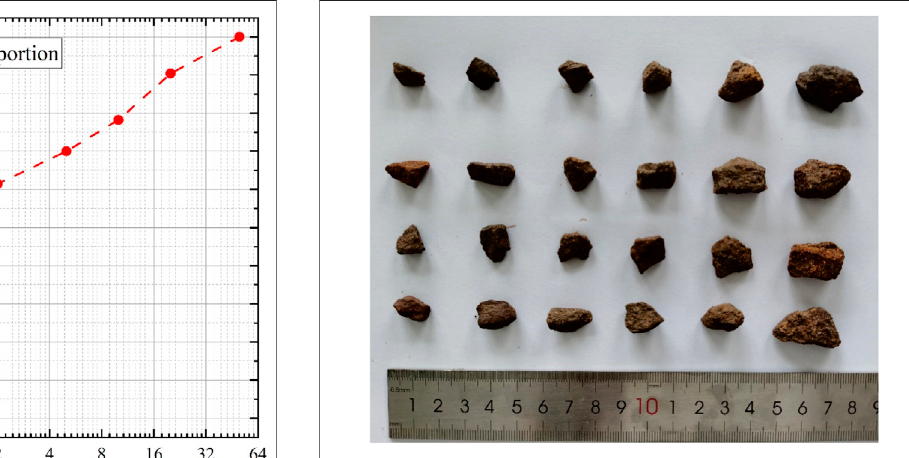
FIGURE 5 | Different sizes of rocks in